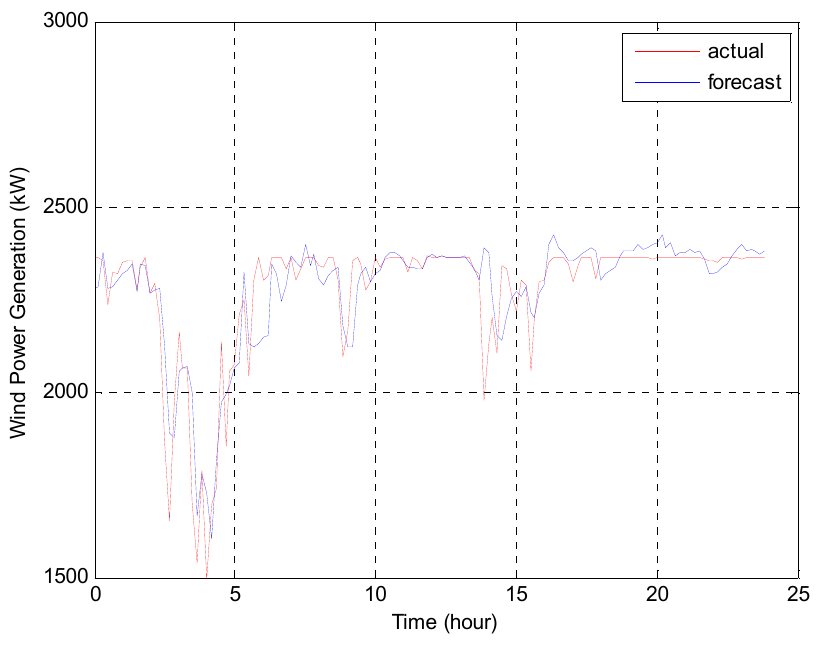
Figure 4. Numerical results with the RBF neural network based method for typical winter day.